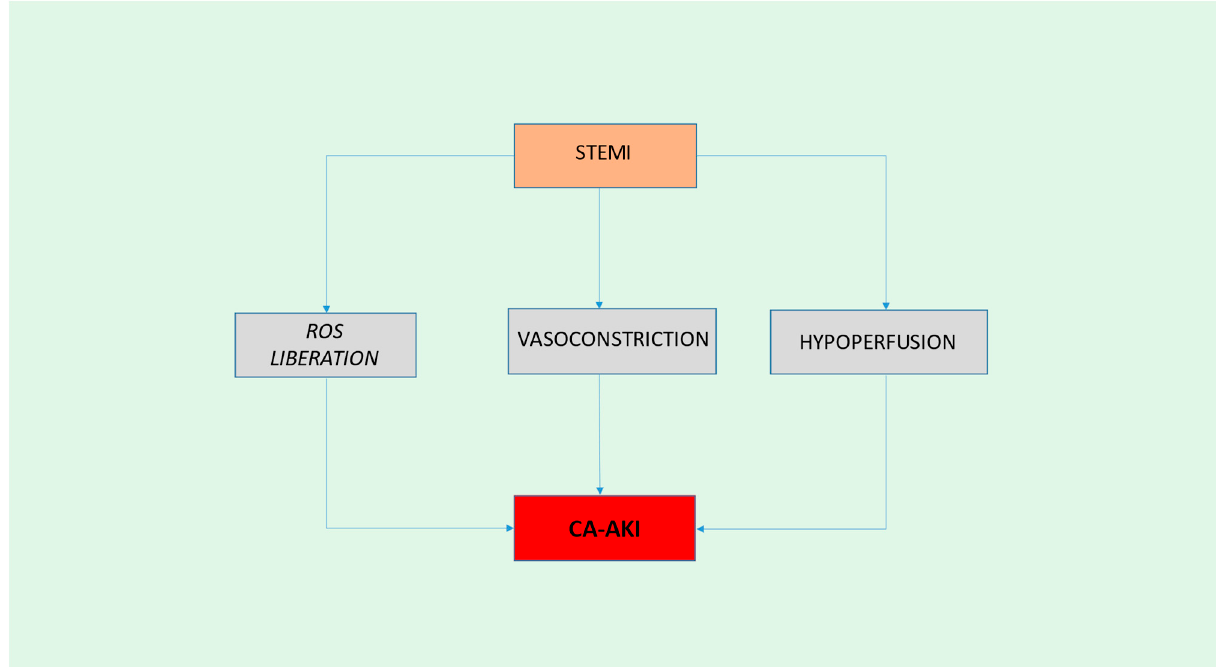
Figure 1. Pathophysiology of CA-AKI. STEMI: ST-elevation myocardial infarction; ROS: Reactive Oxygen Species; CA-AKI: Contrast-Associated Acute Kidney Injury.